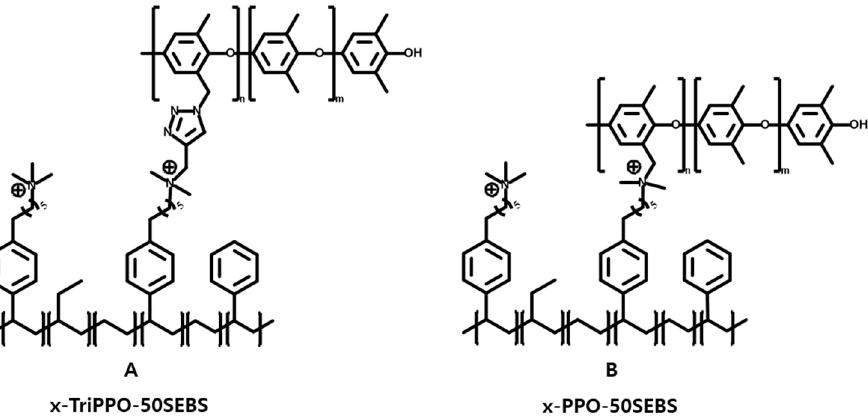
Figure 1. Crosslinked triazole-functionalized PPO with 50% SEBS ( x-TriPPO-50SEBS , ( A )) and crosslinked PPO with 50% SEBS ( x-PPO-50SEBS , ( B ))